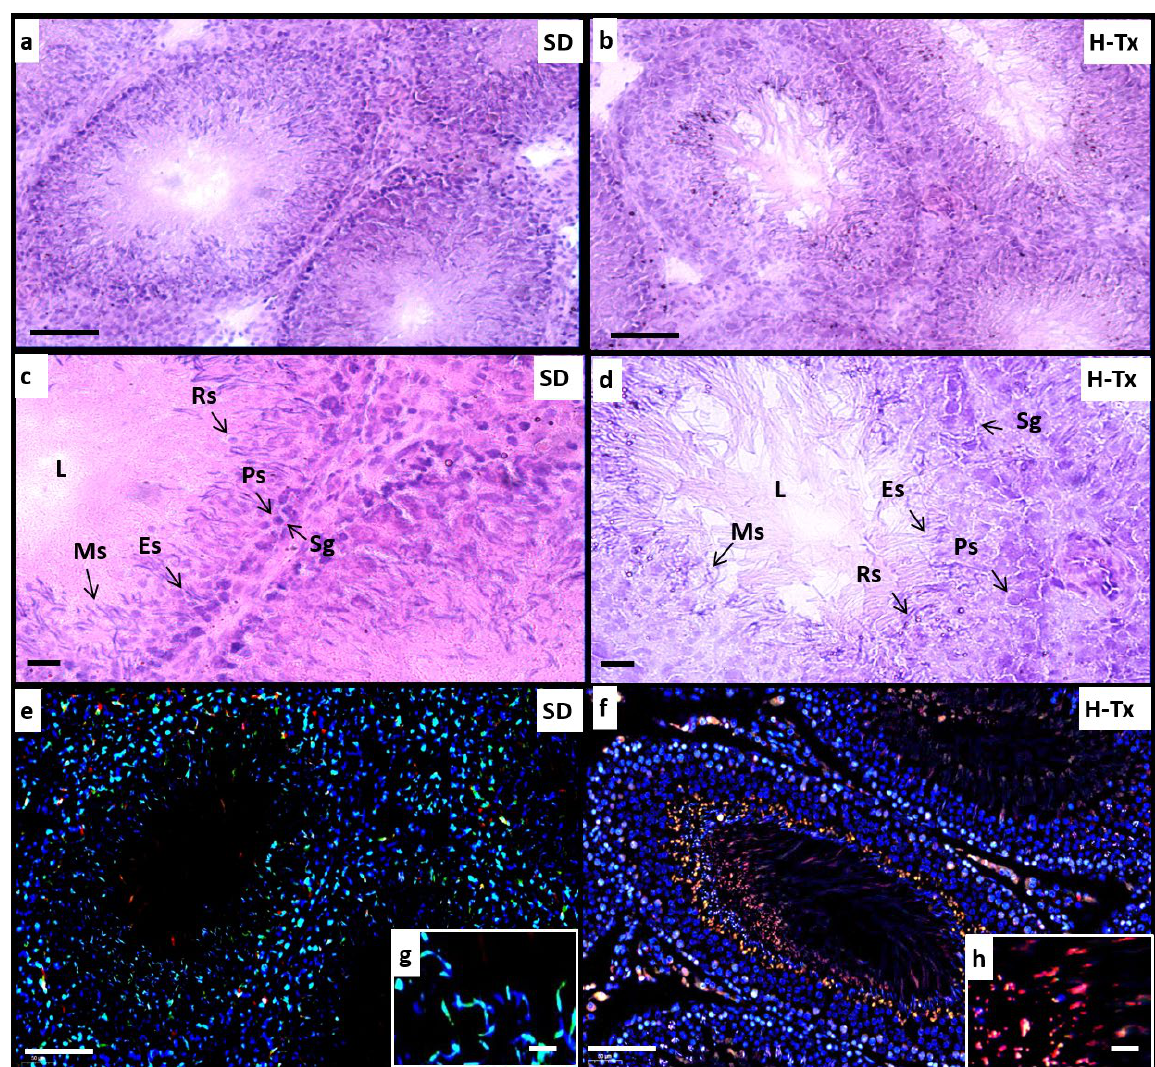
Figure 1. Histochemistry of rat testes. ( a – d ) Haematoxylin and eosin staining to demonstrate histological structure of rat testes. SD and untreated H-Tx rats (( a,b ) at 200 × , scale: 50 µ m and ( c,d ) at 400 × , scale: 25 µ m) demonstrate normal appearance of seminiferous tubules with normal arrangement of spermatogonia (Sg) resting on an intact basement membrane (arrowhead). Normal structure of primary spermatocytes (Ps), round (RS) and elongated spermatids (ES) and mature sperms (Ms). Un- treated H-Tx rats ( b , d ) had degenerated seminiferous tubules, and primary spermatogonia (Sg) were distributed around distorted basement membranes (arrowhead). Numerous vacuolated cytoplasm of round spermatozoa (RS), sperm with small dark nuclei and a distorted lumen (L). Acridine orange staining ( e , f ) of SD rat testes ( e ) gives a green stain indicating cells/sperm with intact and double- stranded DNA. In H-Tx rat testes ( f ) red stain indicates distorted, single-stranded DNA. Orange and yellow stain represents cell death (magnification ( e , f ): 200 × , scale: 50 µ m). Inset ( g , h ) show sperm at higher resolution to illustrate dead and fragmented cells in the H-Tx ( h ) compared to the intact sperm in SD ( g ) (magnification ( g , h ): 800 × , scale: 12.5 µ m). The results are representative of n = 4–6 rats with a minimum of three sections from different locations of